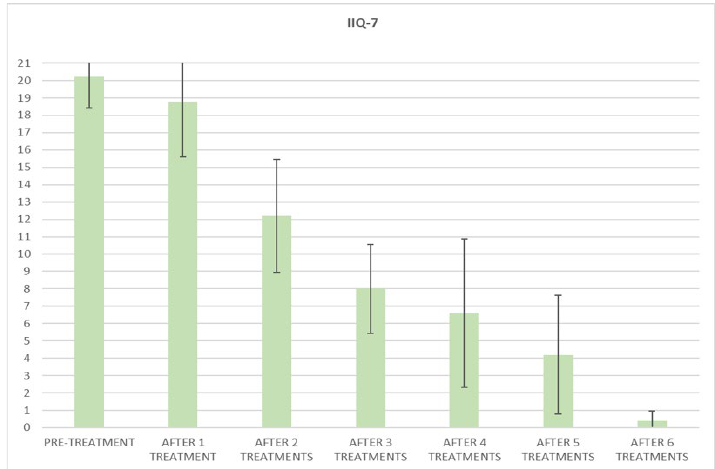
Figure 5. Histogram representation of the results from ICIQ-OAB at baseline and at 3 months follow-up.